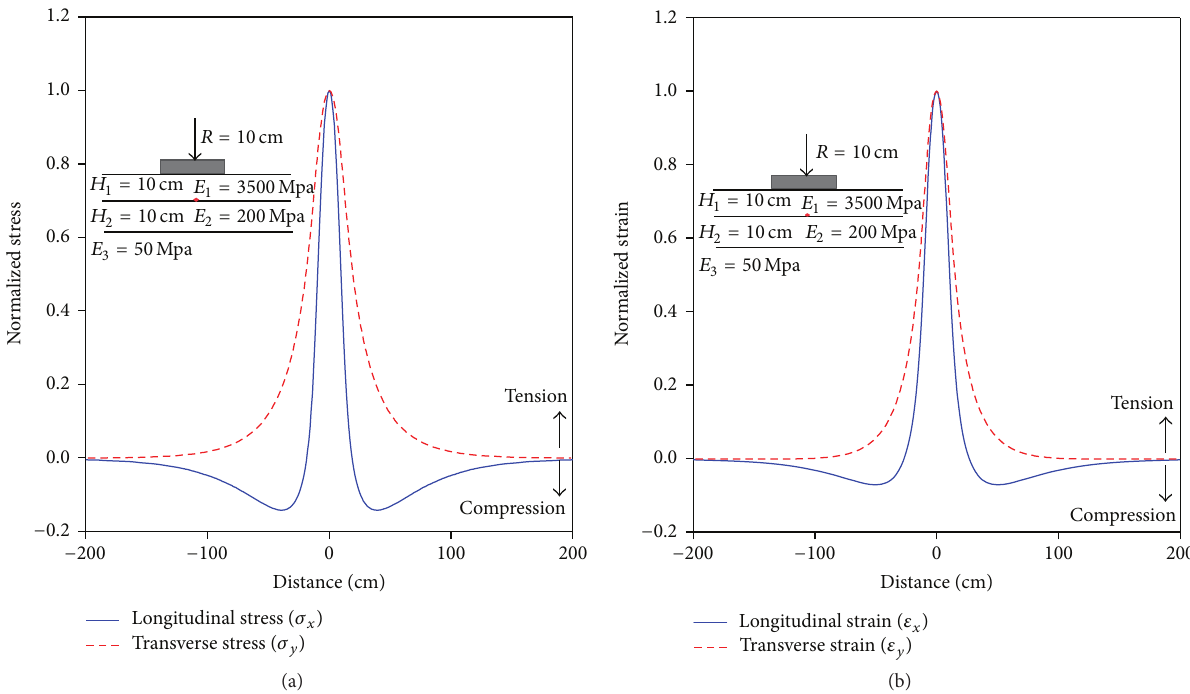
Figure 2: Normalized horizontal response versus distance for a sample pavement